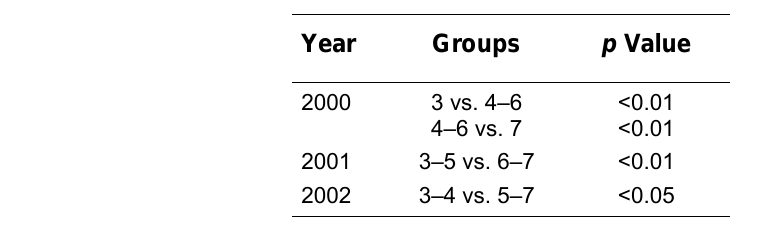
Significant Planned Comparisons from the ANCOVA Analysis